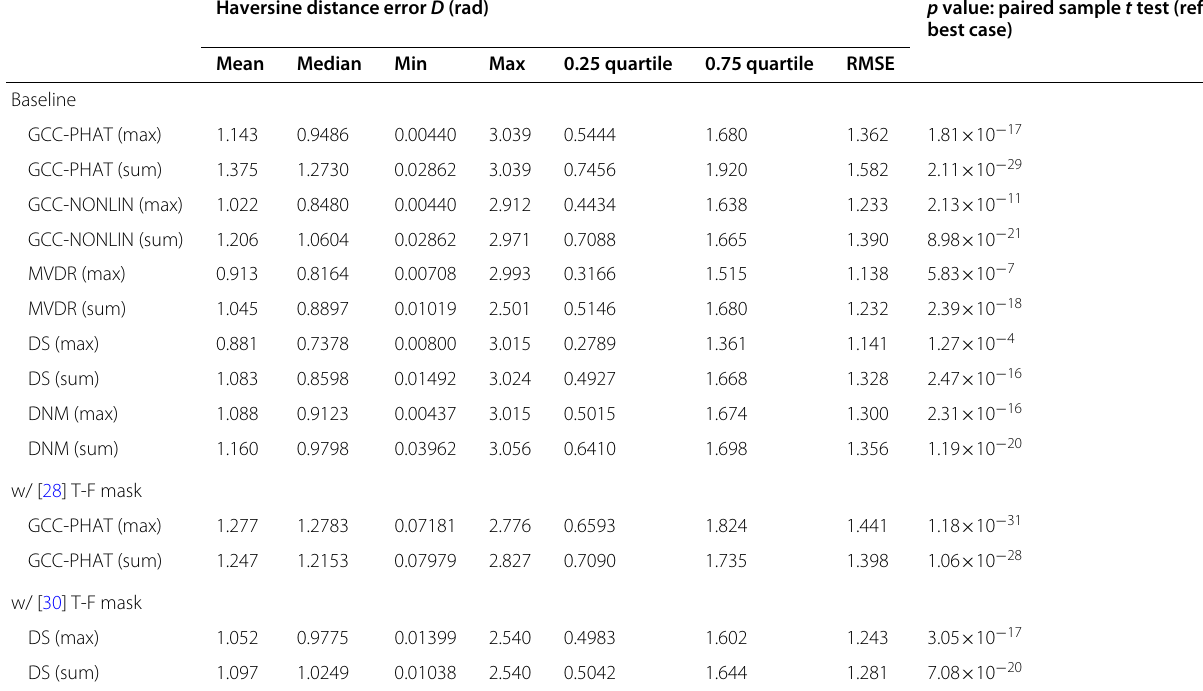
Table 5 Haversine distance error performance comparison (task 3—flying UAV, speech sound